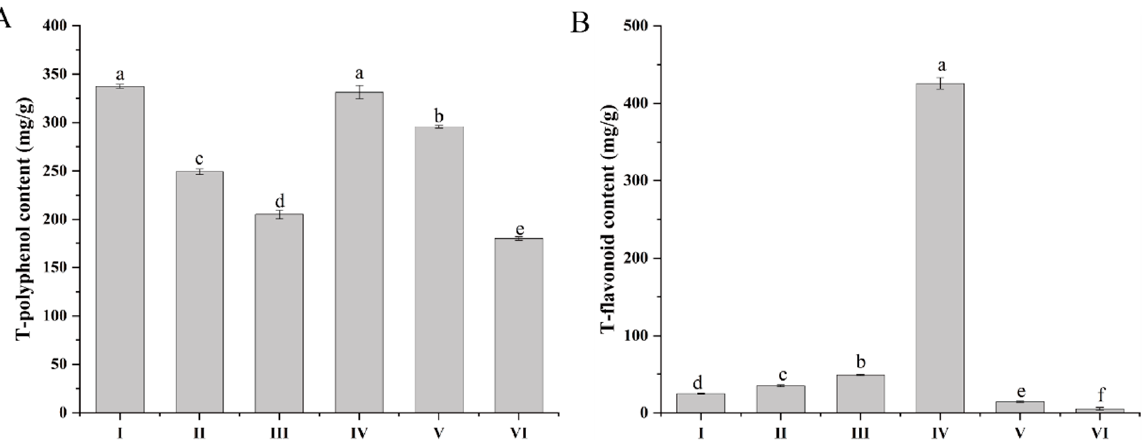
Figure 1. The contents of flavonoids and polyphenols in different extraction fractions. I, ethanol extract; II, PE fraction; III, chloroform fraction; IV, EtOAc fraction; V, n-BuOH fraction; VI, residual ethanol solution fraction. ( A ) Total polyphenol content; ( B ) Total flavonoid content; Different letters (a–f) represent significant differences among groups ( p < 0.05). Values are expressed as the mean ± SD.